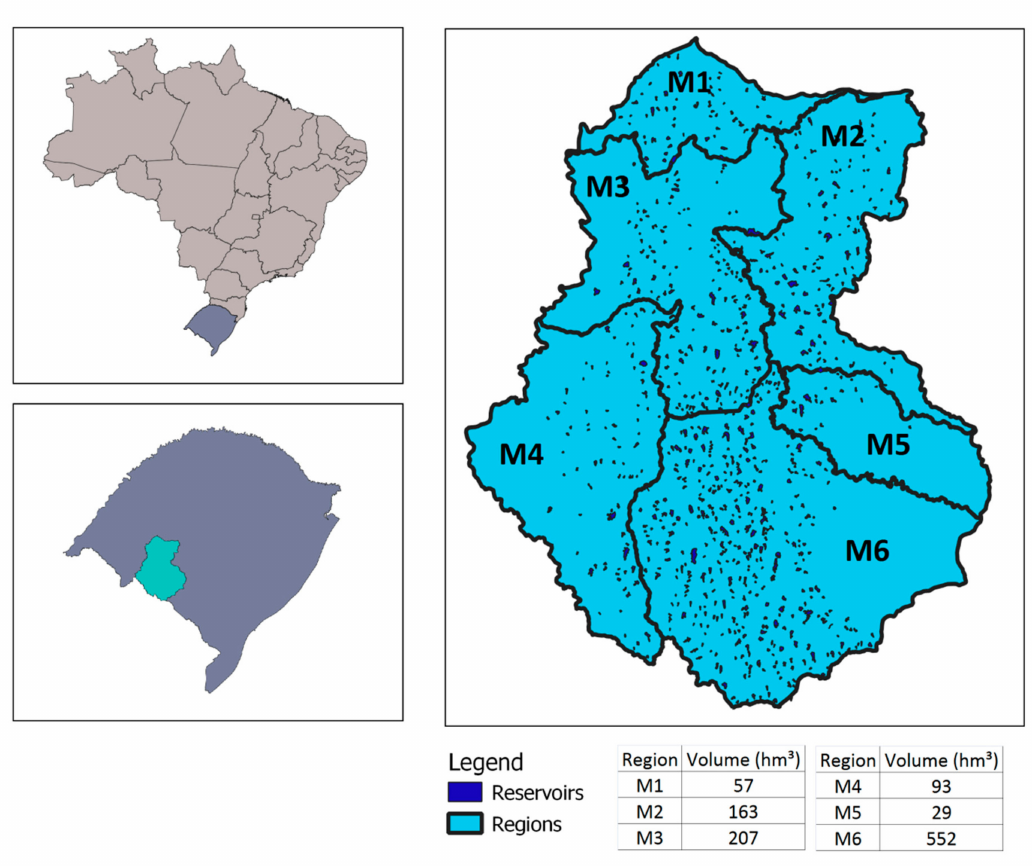
Figure 4. Private reservoirs on the Santa Maria River